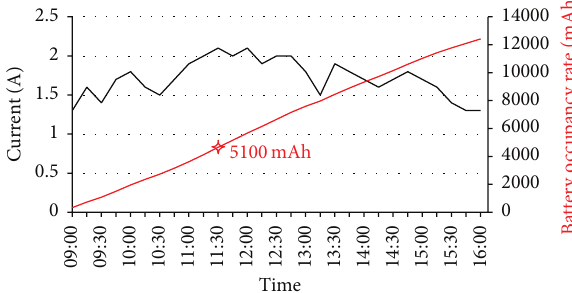
Figure 11: Change in input and current values during charge of batteries.